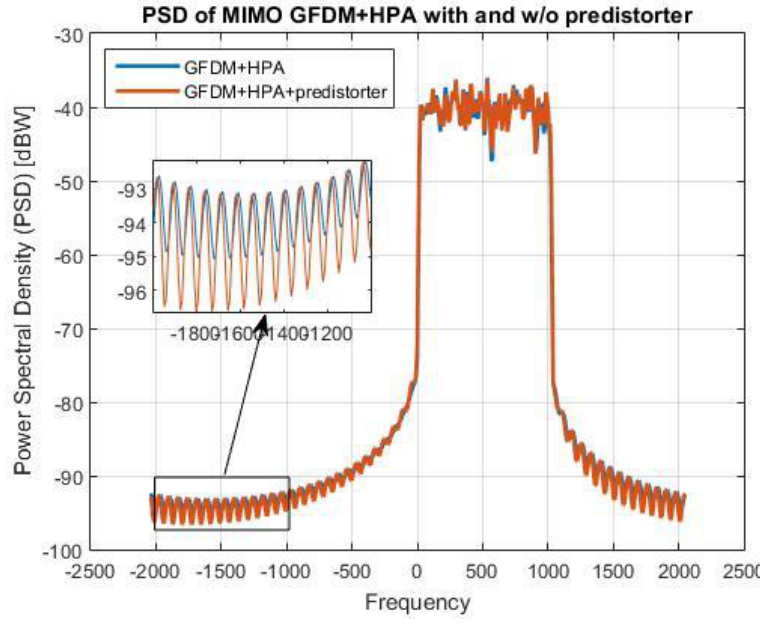
Figure 9. MIMO PSD GFDM with and without predistorter.